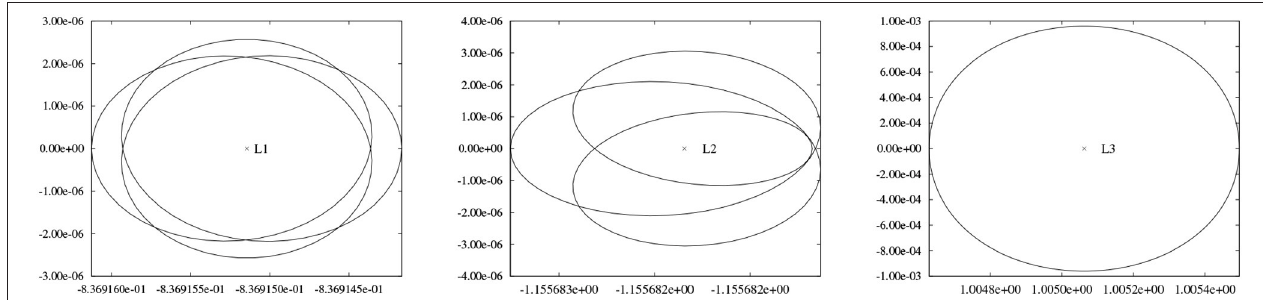
FIGURE 7 | Dynamical equivalents of the collinear points. Left: L 1 . Center: L 2 . Right: L 3 . Horizontal axis: x . Vertical axis: y . See text for more details.